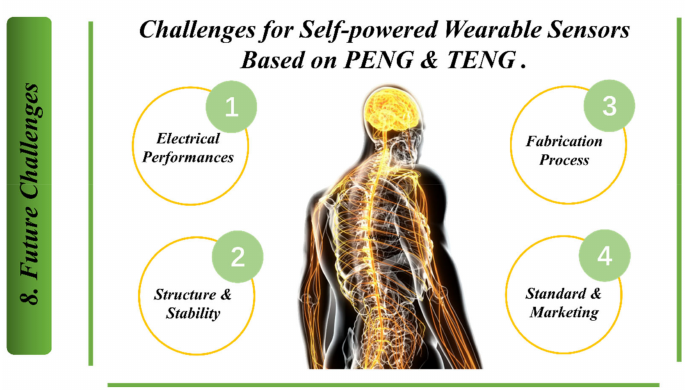
Figure 12. Challenges for self-powered wearable sensors based on piezoelectric nanogenerators (PENG) & triboelectric nanogenerators